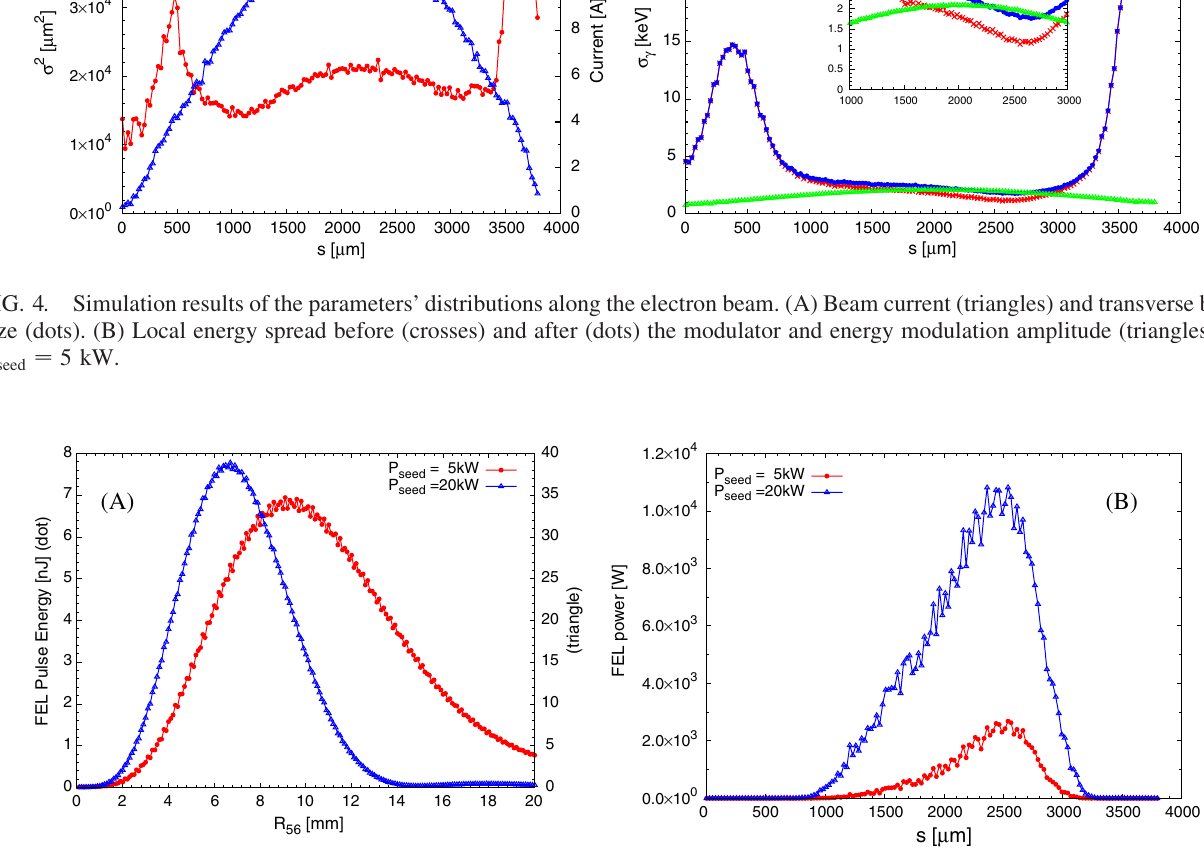
FIG. 5. Simulation results of the CHG radiation signals for both P seed ¼ 5 kW (dots) and P seed ¼ 20 kW (triangles). (A) FEL pulse energies as a function of the DS strength. (B) Output radiation pulses for the corresponding maximal pulse energies in (A).